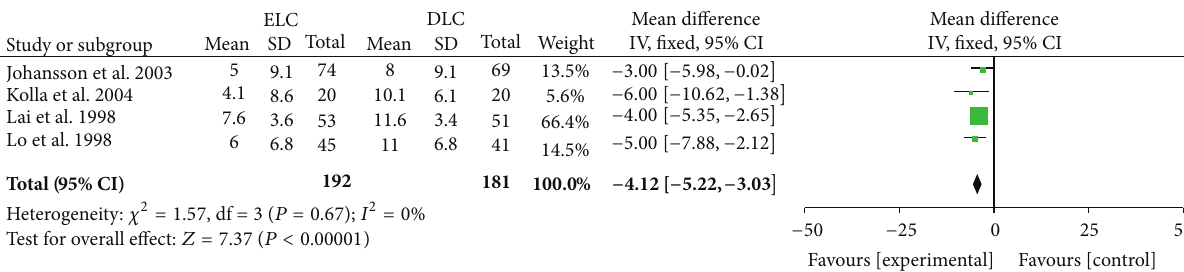
Test for overall effect: Z= 0.68 ( P = 0.50) Figure 3: Meta-analysis of conversion to open cholecystectomy in ELC versus DLC. Risk ratio shown with 95% confidence intervals.